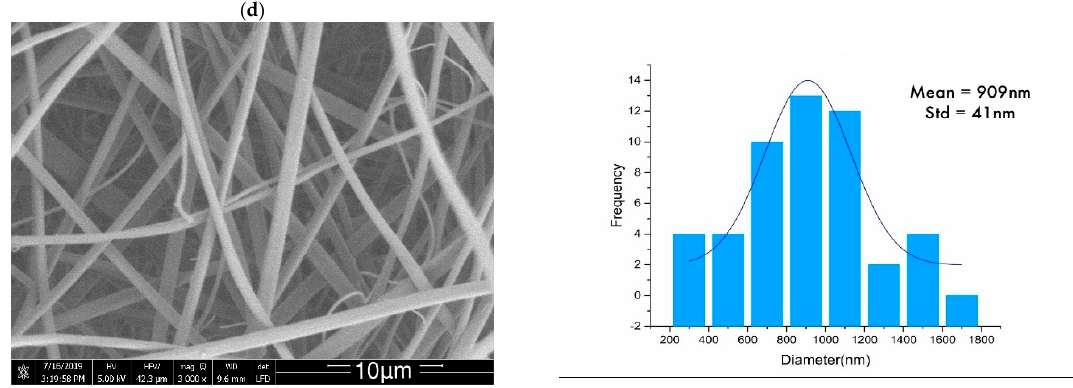
Figure 2. SEM of ( a ) lignin, ( b ) lignin/PAMAM, ( c ) heat-set lignin, and ( d ) heat-set lignin/PAMAM, along with the corresponding fiber dimeter distributions.